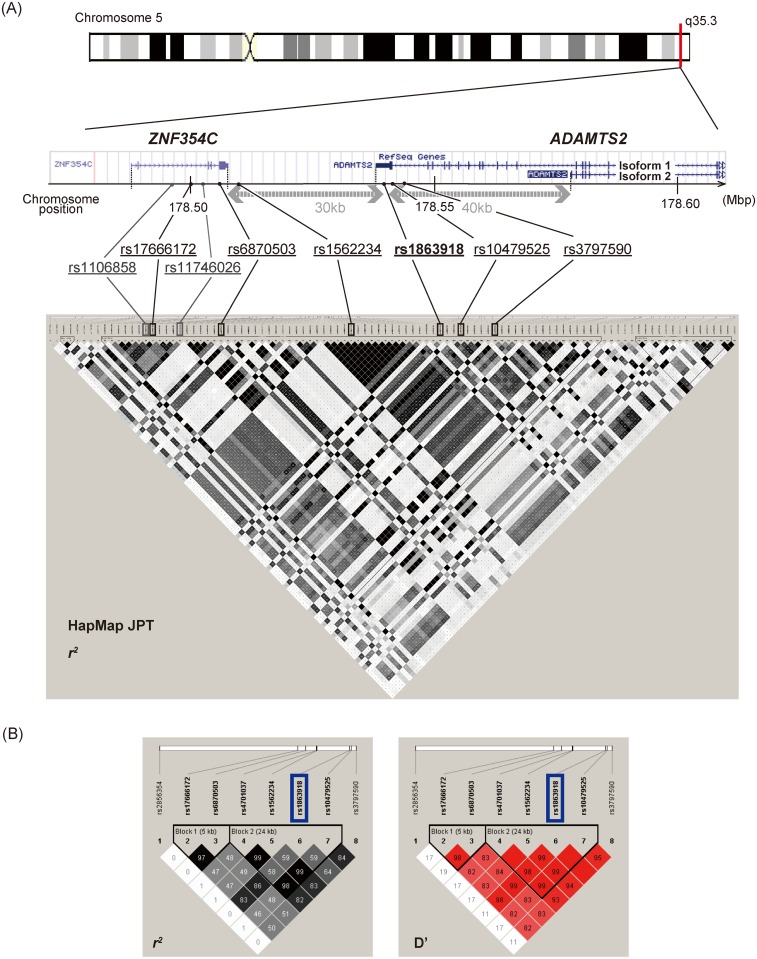
Pairwise linkage disequilibrium (r2) diagrams around the ZNF354c-ADAMTS2 locus.(A) Position on chromosome and pairwise linkage disequilibrium (r2) diagrams in the HapMap JPT around the ZNF354c-ADAMTS2 locus. ADAMTS2 consists of two isoforms; a long form (isoform 1) generally identified as a conventional form and a short form (isoform 2). The SNP rs1863918 lies in the 3ʹ-UTR of ADAMTS2 isoform 1, around 30 kb downstream from ZNF354C, and about 40 kb distant from the ADAMTS2 isoform 2. (B) Estimates of pairwise r2 for 8 SNPs on chromosome 5 in the combined data set of the GWAS and replication samples. The SNPs rs17666172 and rs6870503 were in strong LD with rs1863918 (r2 = 0.83 for rs17666172; r2 = 0.86 for rs6870503).